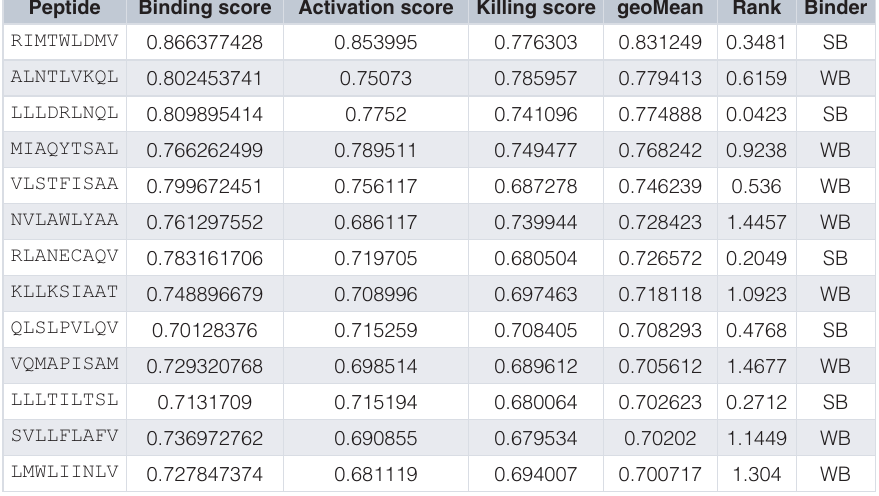
Table 4. 2019-nCoV 9-mer peptides with geometric mean ≥ 0.7 by 1G4 TCR positional weight matrix and predicted positive to bind HLA-A*02:01 by NetMHCpan 4.0 (Rank = NetMHCpan rank).